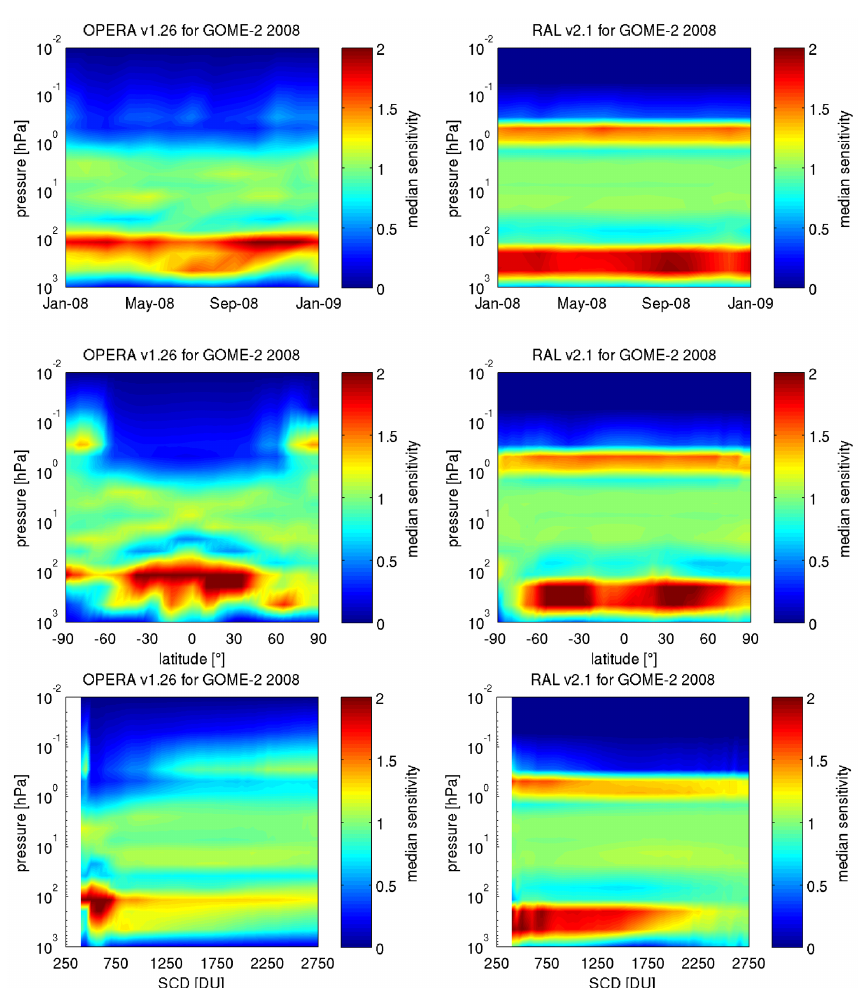
Figure 5. OPERA v1.26 (left) and RAL v2.1 (right) GOME-2 (2008) median sensitivity profiles as a function of time (top), latitude (middle), and slant column density (SCD, bottom) for the global coverage data